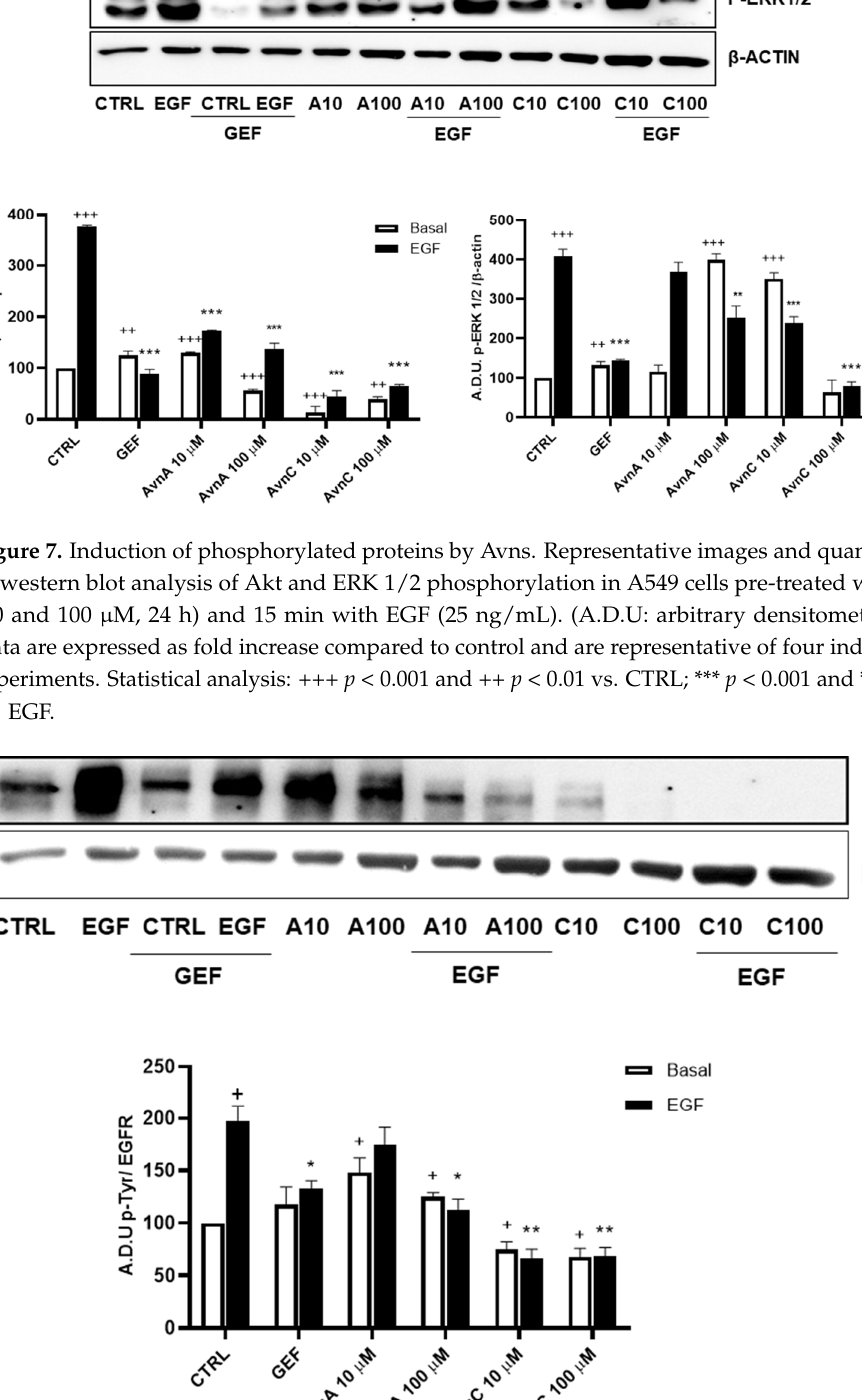
Figure 8. Regulation of EGFR phosphorylation by Avns. Representative images and quantification of western blot analysis of p-EGFR in A549 cells treated with Avns (10 and 100 µ M, 48 h). (A.D.U: arbitrary densitometry units). Data are expressed as fold increase compared to control and are representative of three independent experiments. Statistical analysis: + p < 0.05 vs. CTRL; ** p < 0.01 and * p < 0.05 vs. EGF.